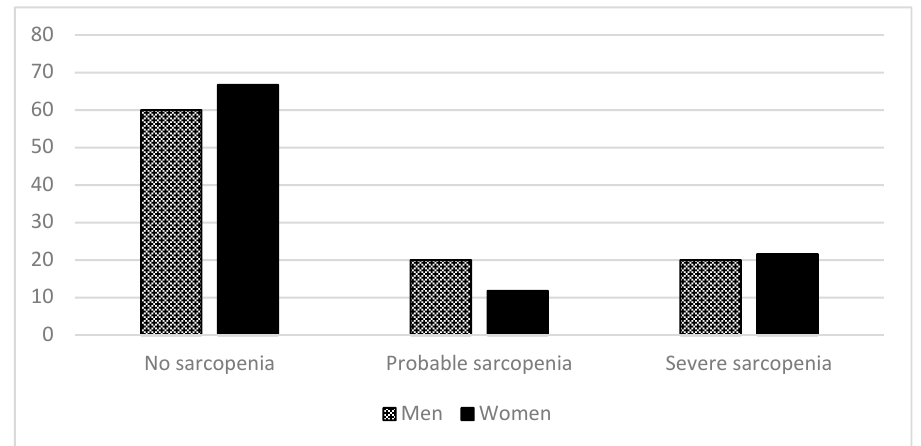
Figure 2. Percentages of no sarcopenia and severity sarcopenia levels (EWSGOP2, 2019) according to gender: no sarcopenia, probable sarcopenia, and severe sarcopenia.